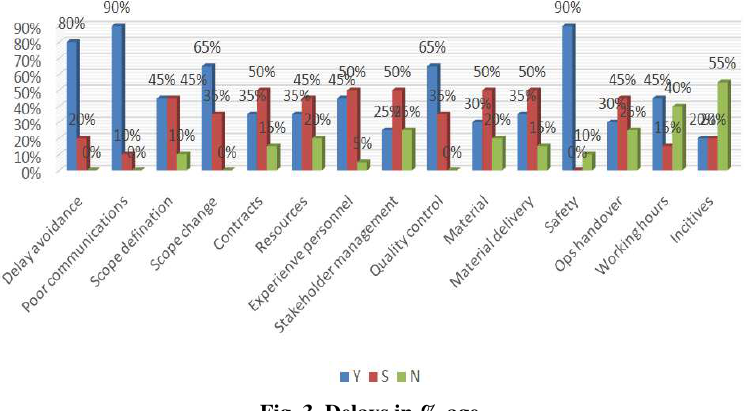
Fig. 3. Delays in % age